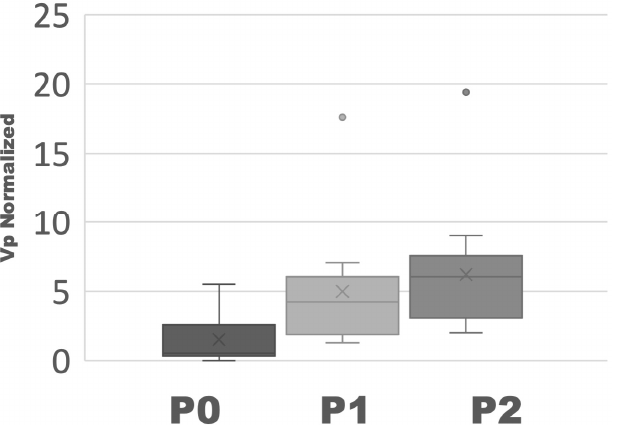
Figure 3. Box and whisker plot of V p ( n = 18). One circle in P1 and one circle in P2 are represented as outliers.